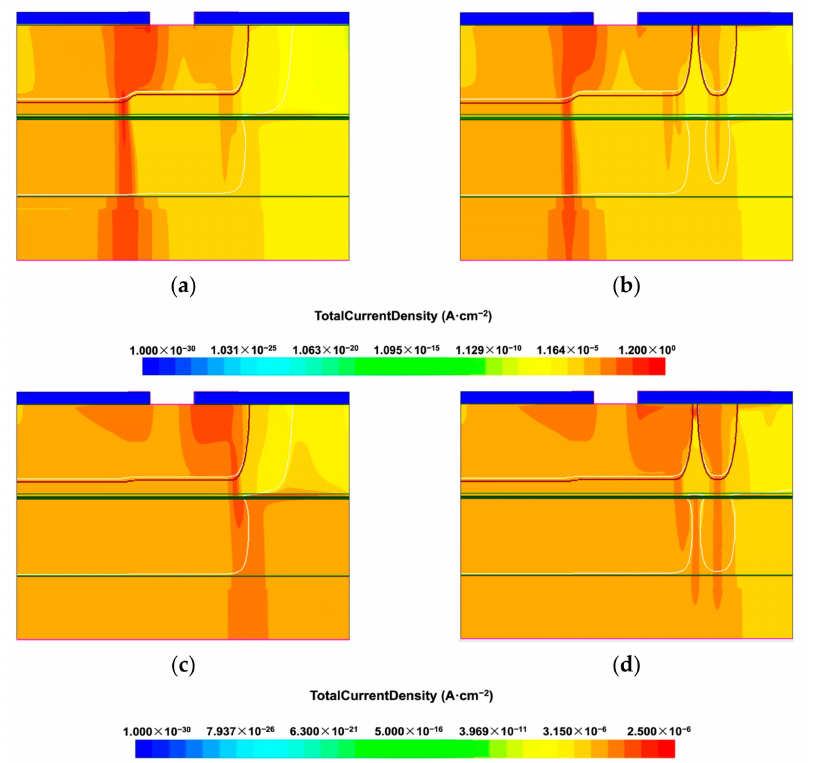
Figure 10. Current density distribution in the device with different guard ring structures: ( a ) AGR with a diffusion depth of 2.73 µ m only; ( b ) AGR and FGR with the same diffusion depth, 2.73 µ m, with the AF spacing of 6 µ m; the color bar for ( a , b ) is displayed below the figures. ( c ) AGR with a diffusion depth of 2.95 µ m only; ( d ) AGR and FGR with the same diffusion depth, 2.95 µ m, with the AF spacing of 6 µ m; the color bar for ( c , d ) is displayed below the figures. In ( a , b ), the bias voltage is − 52.85 V. The breakdown voltages for the device in ( a , b ) are − 52.85 V and − 52.96 V, respectively. In ( c , d ), the bias voltage is − 48.59 V. The breakdown voltages for the device in ( c , d ) are − 48.59 V and − 48.68 V,